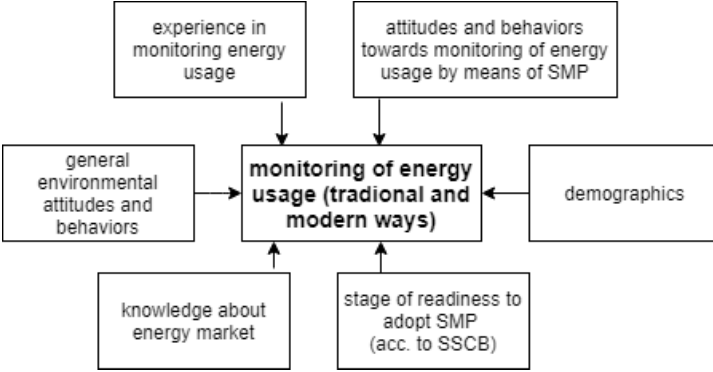
Figure 1. Main determinants of monitoring the energy usage in general and by means of SM